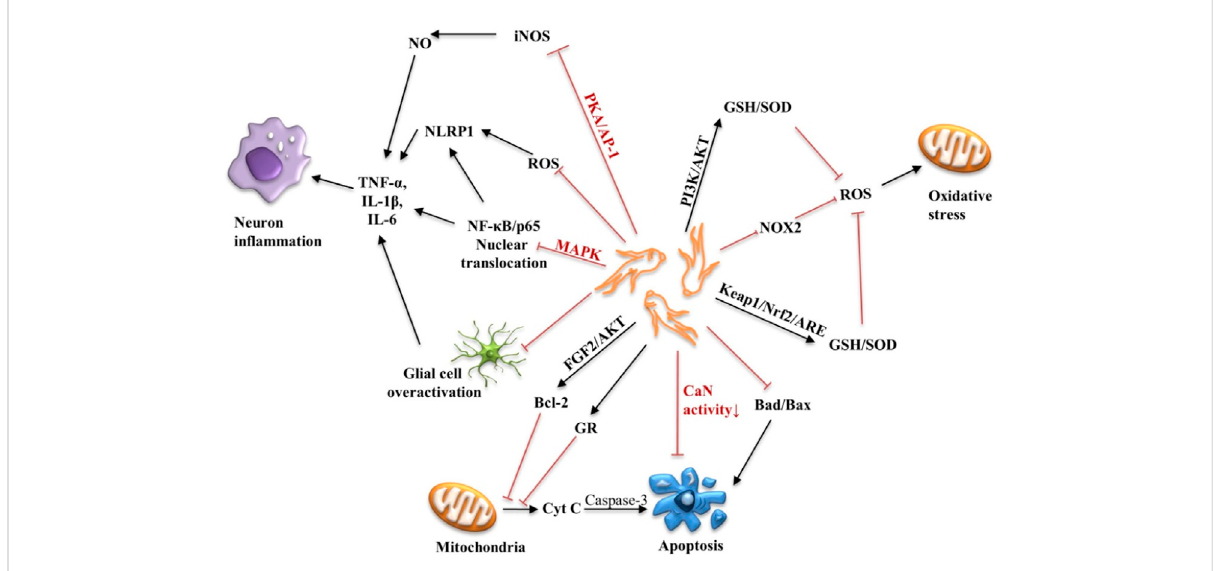
FIGURE 4 Schematic diagram of the neuroprotective mechanism of ginsenosides. PKA, protein kinase A; AP-1, activator protein 1; MAPK, mitogen- activated protein kinase; NF- κ B, nuclear factor Kappa B; TNF- α , Tumor necrosis factor α ; IL-1 β , Interleukin-1 β ; IL-6, Interleukin-6; FGF, fi broblast growth factor; GR, glucocorticoid receptor; cyt C, cytochrome C; Keap1, Kelch-like epoxy chloropropane-related protein-1; Nrf2, nuclear factor erythroid 2-related factor 2; ARE, antioxidant response element; NOX2, NADPH-Oxidase 2; PI3K, phosphoinositol 3 kinase; SOD, superoxide dismutase; GSH,